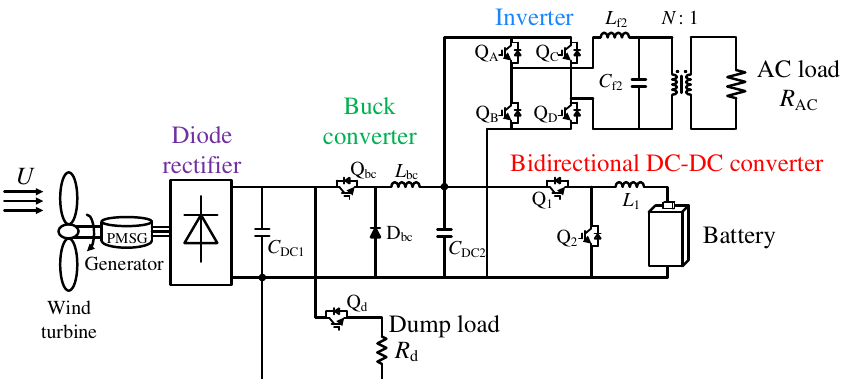
Figure 3. Standalone WPGS with diode rectifier and non-isolated bidirectional DC-DC converter in